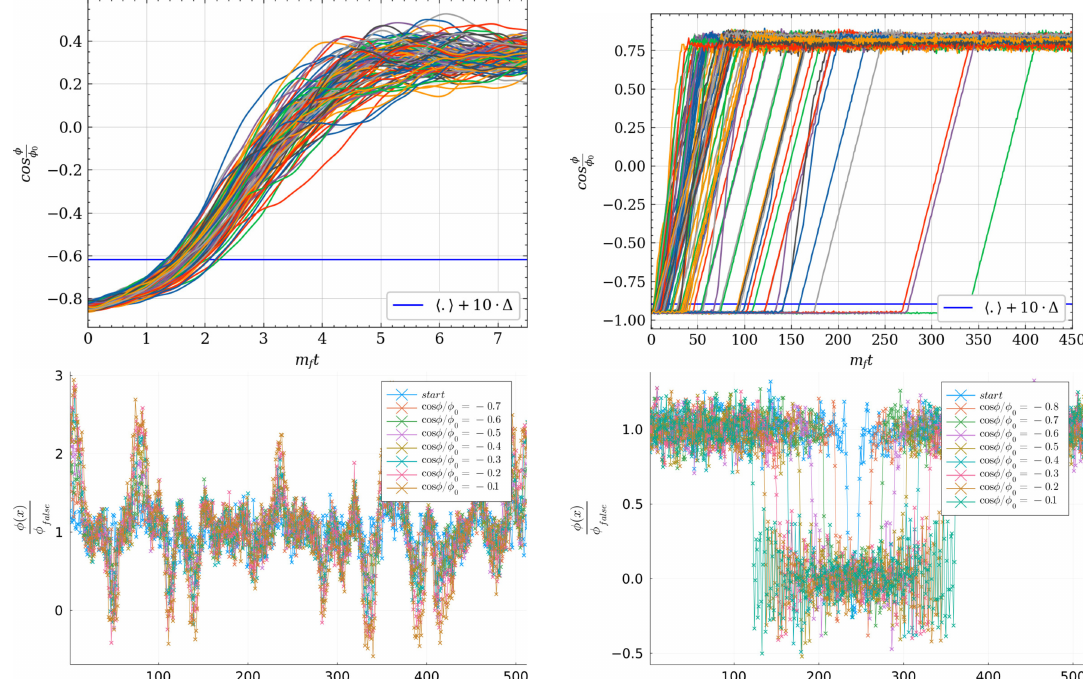
Figure 7 . The time evolution of h cos( φ/φ 0 ) i (top) for (cid:15) = 1 . 0 (left) and (cid:15) = 0 . 5 (right). Below are examples of configurations of one of the simulations. Other simulation parameters are N dt = 0 . 05 , φ 0 = 1 . 2 , am f = 0 . 3 . Each ensemble consists of 100 individual